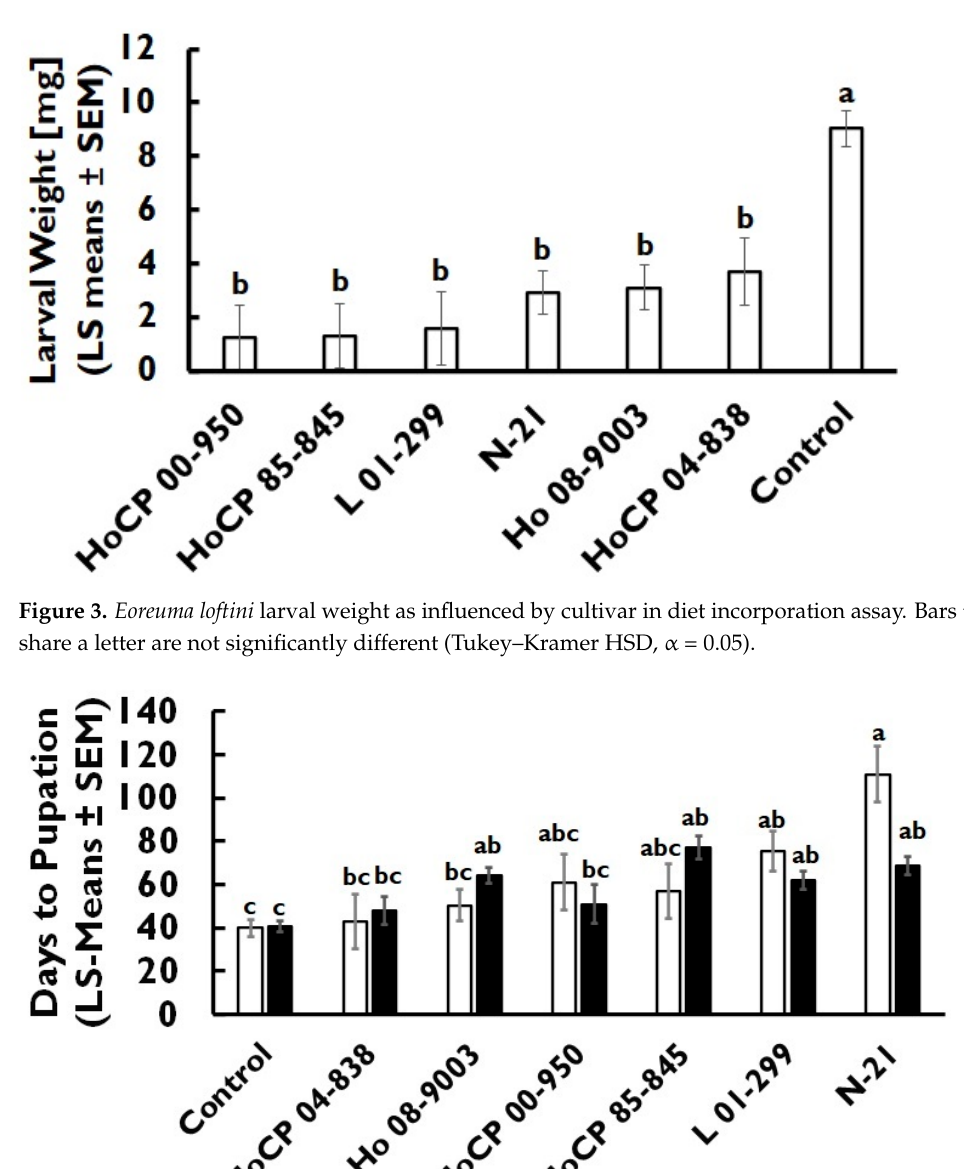
7 of 12 Figure 2. Eoreuma loftini neonate establishment among commercial sugarcane cultivars in green- house trial. Bars with the same letter do not differ significantly (Tukey–Kramer HSD, α = 0.05). Standard error of means analyzed with a binomial distribution are reported. 3.4. Diet Incorporation Assays All evaluated cultivars reduced larval weight by 59.2–86.5% relative to the artificial diet control but were not significantly different from each other ( F = 12.33; df = 6, 146.5; p < 0.001; Figure 3). Pupal weight ranged from 29.2–39.1 mg and was influenced by sex ( F = 21.31; df = 6, 73.2; p < 0.001), but was not influenced by cultivar ( F = 0.48; df = 6, 76.0; p = 0.822), or the interaction of cultivar and pupae sex ( F = 0.07; df = 6, 70.4; p = 0.998). Pupal